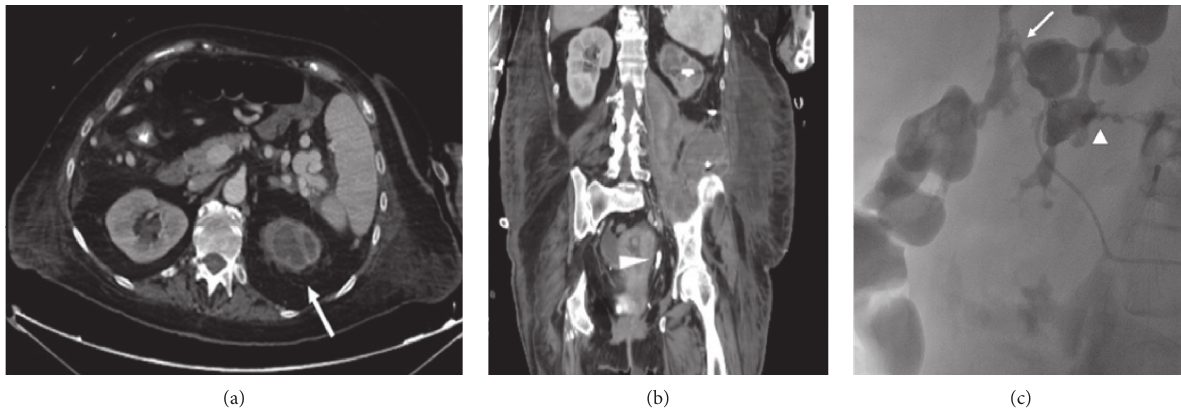
Figure 1: (a) Postcontrast CT images showed hypoperfusion of the left kidney with thinning of the cortex; dilatation of the left kidney excretory system with a “bear’s paw sign” is also depicted suggesting diagnosis of xanthogranulomatous pyelonephritis (arrow); (b) postcontrast coronal reconstruction demonstrated ureteral stone (arrowhead) in the distal tract of the left ureter without significant dilatation of the proximal tract; (c) oblique projection pyelography after puncture of the inferior calix of the left kidney demonstrated leakage of contrast media with a double fistulous path form the pelvis directed anteriorly to the left colon (arrow) and posteriorly to the collection in the retroperitoneal collection